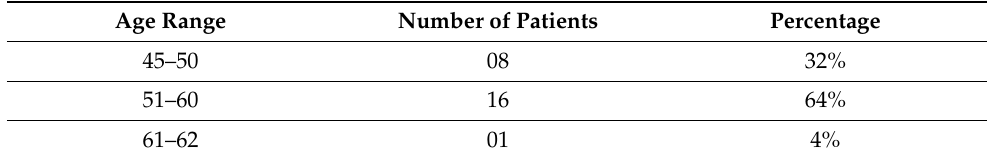
Table 1. Age distribution of participants.